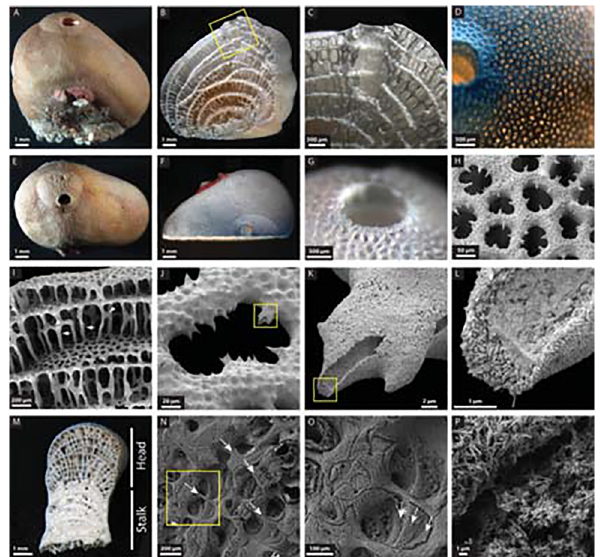
Fig 1. General morphological features of Vaceletia sp. and its CaCO 3 skeleton. (A) A lateral view of a fixed animal. The exhalent siphon (arrow) is clearly visible. (B) A sagittal section view after treatment with NaOCl and grinding to reveal the interior structure of the skeleton. (C) Magnification of the boxed section in B illustrates the structure of the siphon and pillars which support each terraced chamber. The ontogenetically youngest chamber is at the top of the animal (arrow). (D) An apical view with transmitted light through the specimen following NaOCl treatment to highlight the elaborate structure of the ostia. (E) An apical view of the intact animal. (F) An apical view of the animal following treatment with NaOCl and grinding to the sagittal plane. (G) Magnified view of the siphon following treatment with NaOCl. (H) SEM image of the ostia illustrating the unique pattern of inward facing spines. (I) SEM image roughly equivalent to the boxed section in B. Pillars (arrows) support each chamber, and are reinforced by radial spines (arrowhead). (J) Magnification of an ostium. (K) Magnification of the damaged inward facing spine boxed in J. (L) Magnification of the tip of the damaged spine boxed in K. Individual crystals of aragonite are clearly visible. (M) A sagittal section view after treatment with NaOCl and grinding shows the head and hypercalcified stalk regions. (N) SEM image of the stalk region after being etched with EDTA. Note that the pillars of the skeleton are still visible (arrows). (O) Magnification of the boxed section in N shows that the chambers are mineralized in layers (arrows). Note that not all chambers are mineralized entirely. (P) Both pillars and mineralized chambers are constructed by needles of